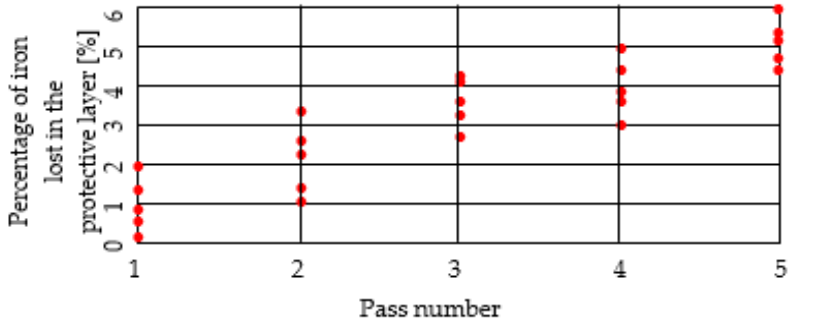
Figure 9. The evolution of Fe percentage lost in the steel wiredrawing process (variant 2 of the protective layer).